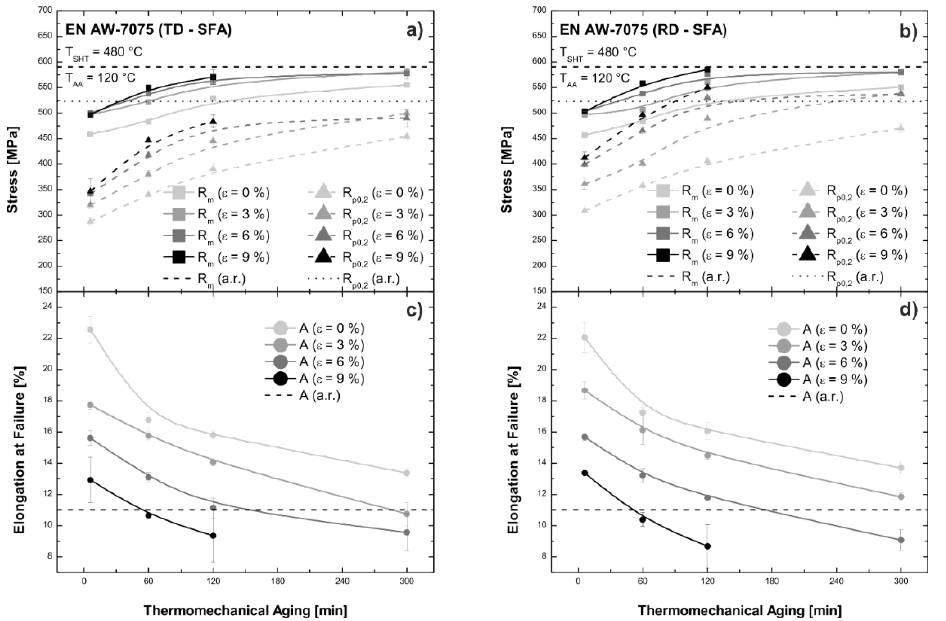
Figure 5. Influence of aging duration and strain on mechanical properties of AA7075 for thermo- mechanical aging strategy “ Simultaneous Forming and Aging ” ( a ) and ( c ) transverse and ( b ) and ( d ) parallel to the rolling direction. All specimens are taken from the thermo-mechanically aged conditions and are tested at room temperature.